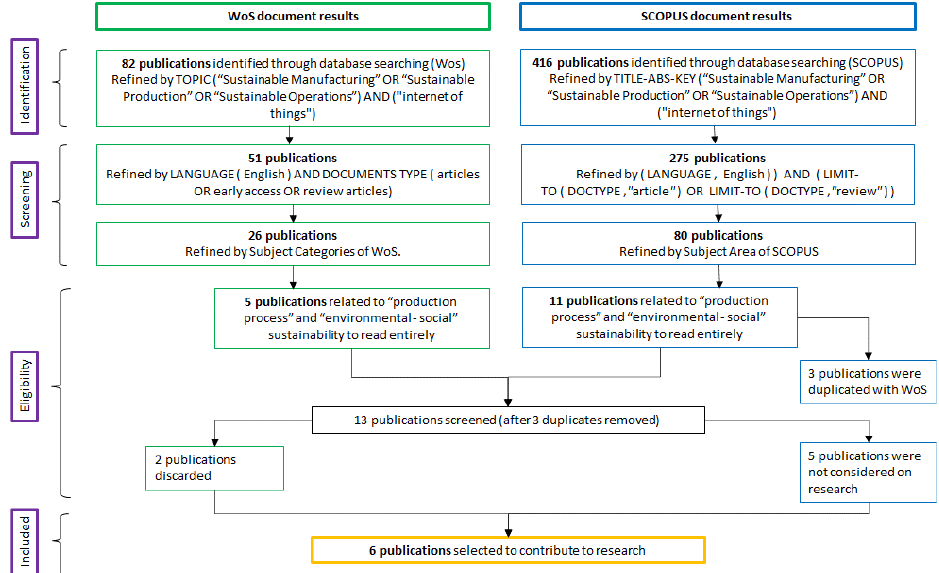
Figure 2. PRISMA process: (1) identification phase; (2) screening phase; (3) eligibility phase; (4) in- clusion phase. sion